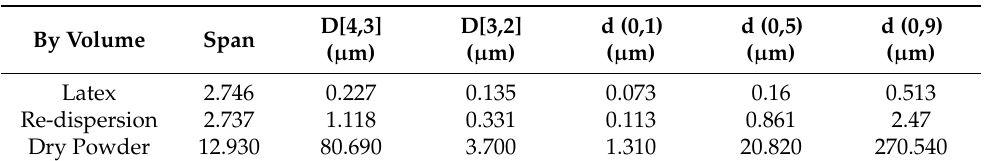
Table 5. Particle size distribution characteristics for the synthesized latex particles, the dried particles, and the re-dispersed particles in water.